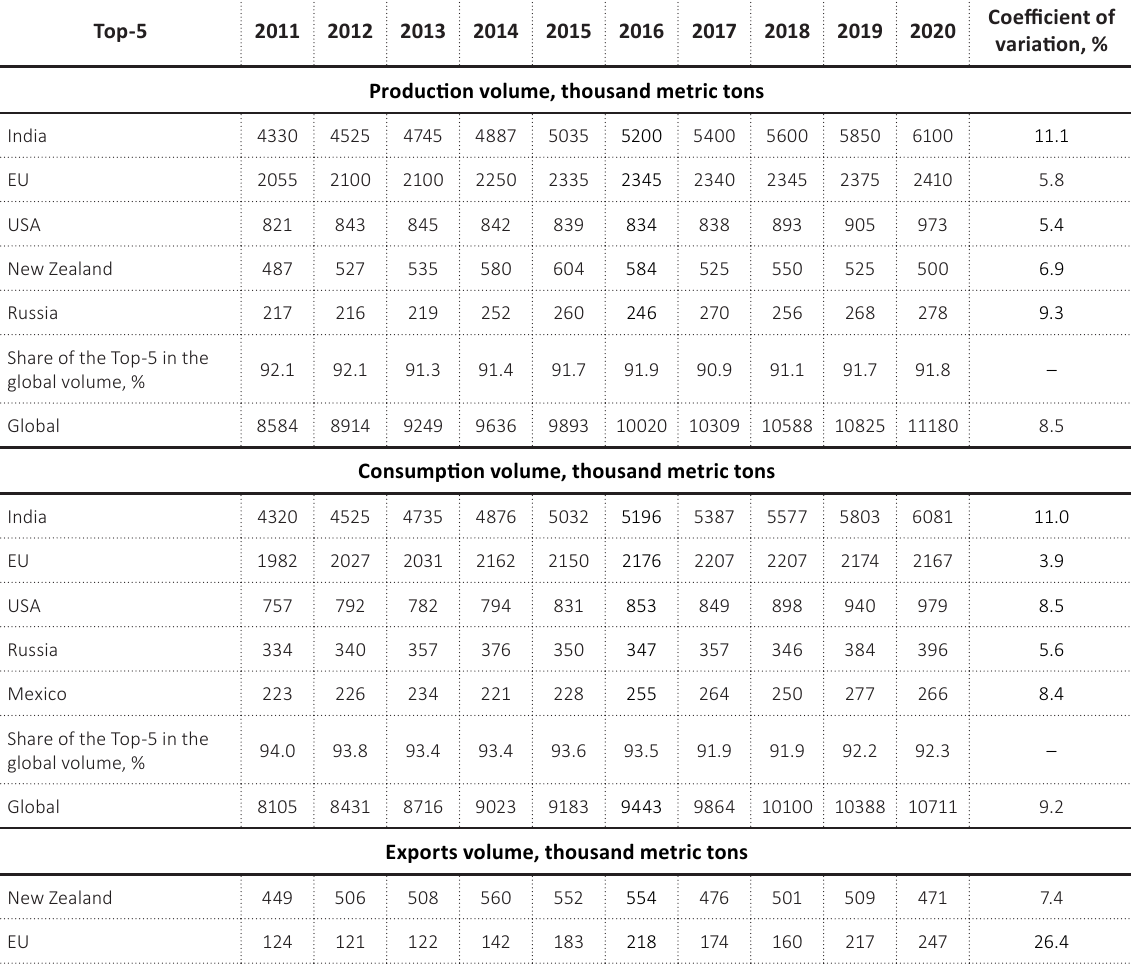
Table A2. Coefficient of variation for the dynamic set of indicators of the global butter market